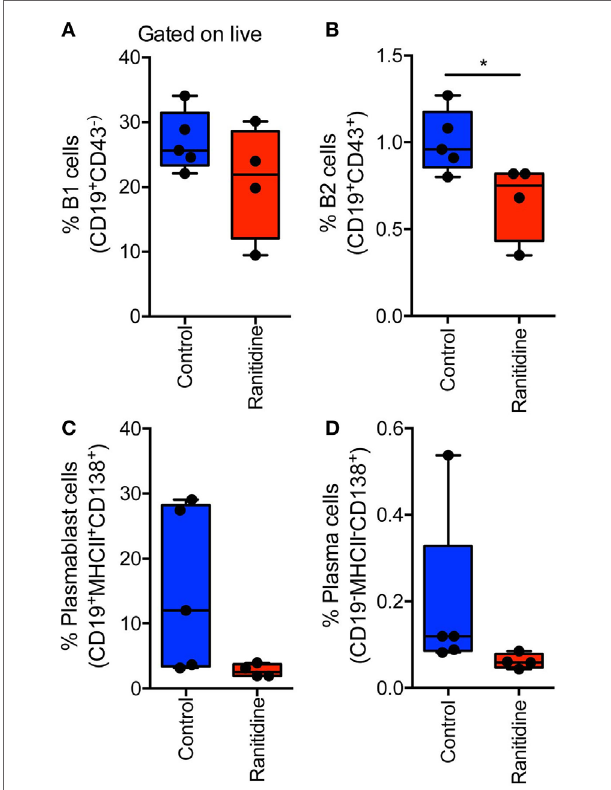
FigUre 6 | Ranitidine significantly decreases B2 cells in the draining lymph nodes of E0771-GFP tumor-bearing C57BL/6 mice. Draining inguinal lymph nodes were isolated from E0771-GFP tumor-bearing mice (ranitidine-treated and control) and cells were stained for B1 cells [CD19 + CD43 − ; (a) ], B2 cells [CD19 + CD43 + ; (B) ], plasmablasts [CD19 + MHCII + CD138 + ; (c) ], and plasma cells [CD19 − MHCII − CD138 + ; (D) ]. Boxplots represent mean and range from individual mice. * p < 0.05, unpaired t